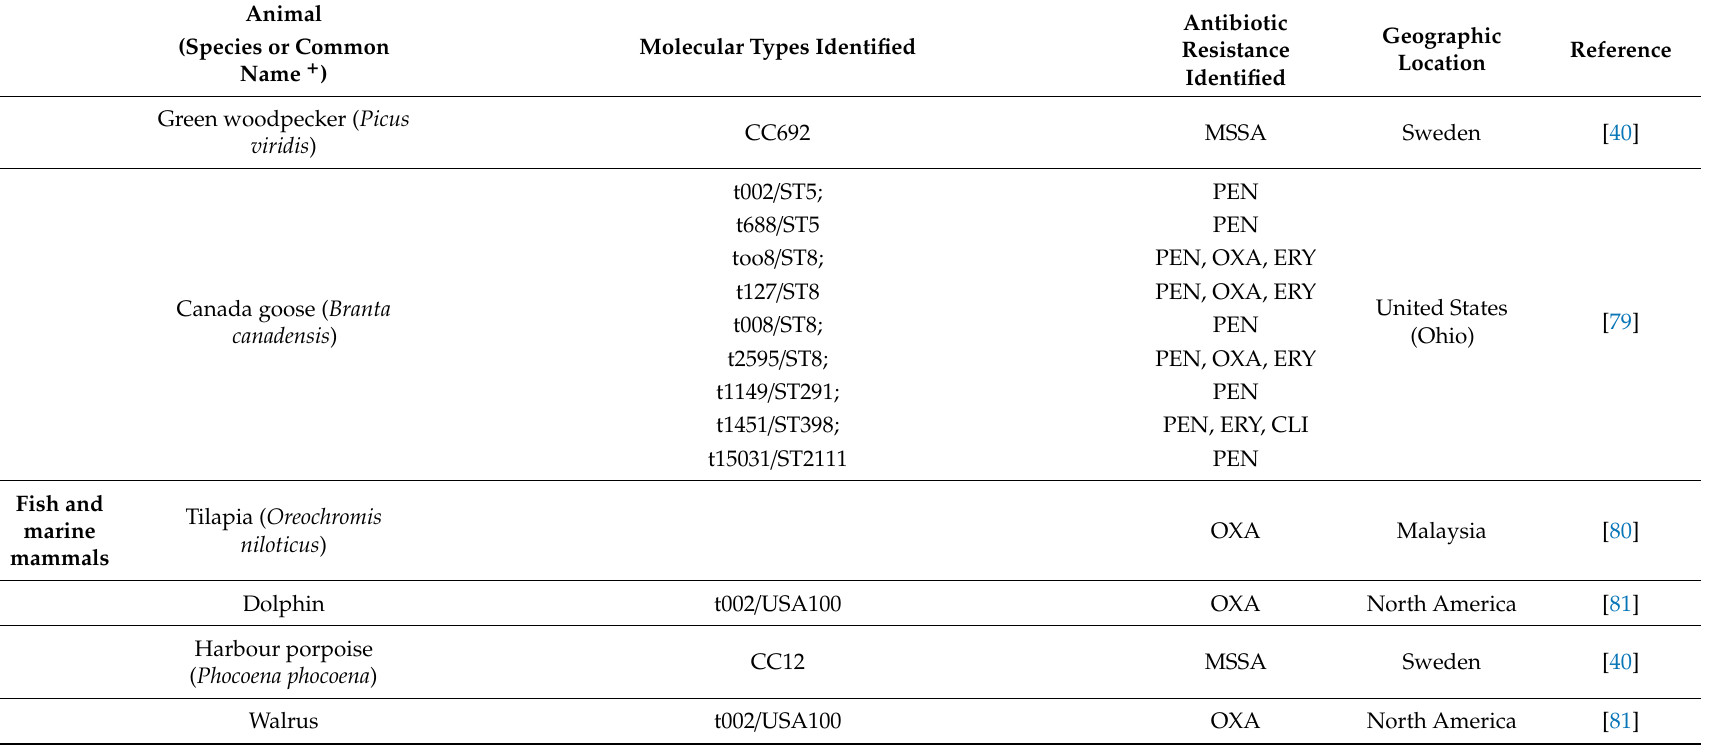
Table 1: Abbreviations: PEN: penicillin; OXA: oxacillin; FOX: cefoxitin; ERY: erythromycin; CLI: clindamycin; STR: streptomycin; KAN: kanamycin; BAC: benzalkonium chloride; RIF: rifampicin; AMP: ampicillin; CIP: ciprofloxacin; GEN: gentamicin; SXT: trimethoprim-sulfamethoxalzole; TMP: trimethoprim; SMX: sulfamethoxazole, LVX: levofloxacin; AMX: amoxicillin; IPM: imipenem; CFZ: cefazolin; FUS: fusidic acid; BLA: β -lactams; CHL: chloramphenicol; Q-D: quinupristin-dalfopristin; FQ: fluroquinolones; hGISA: heterogeneous glycopeptide-intermediate S. aureus. I: inducible resistance. *: resistance due to mecC gene ND: not determined. NT: non-typeable. + : species name only provided if listed